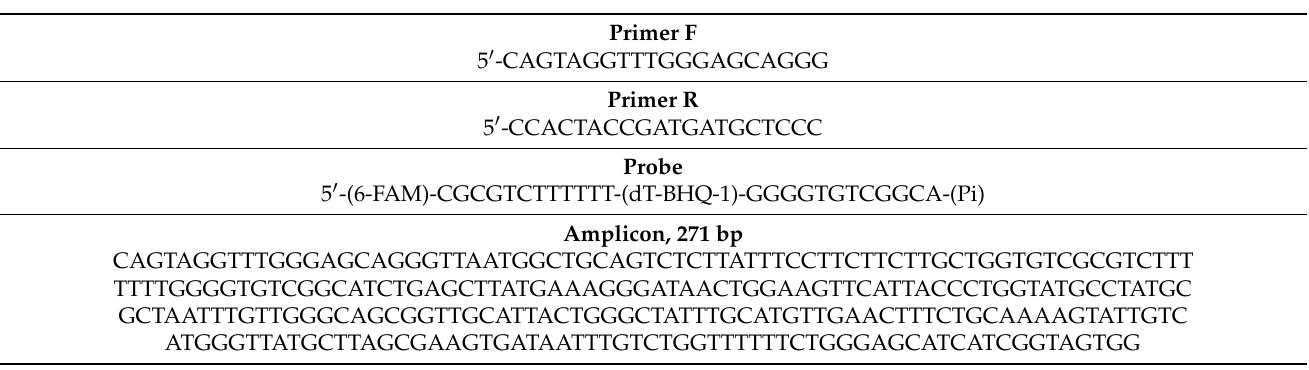
Table 1. Species-specific sequences of generated primers and probe for Pectobacterium atrosepticum PCR detection.